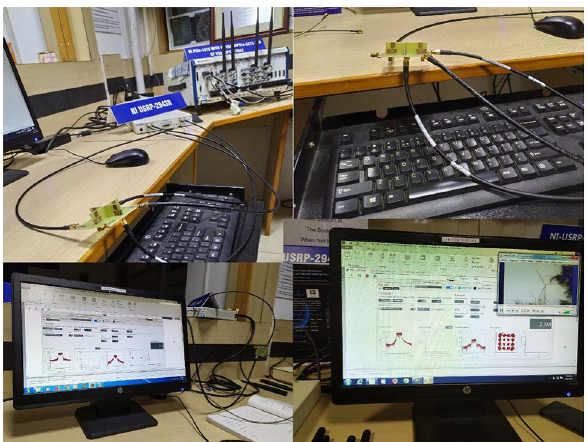
Figure 25. Functional verification lab set up of the two element UWB MIMO